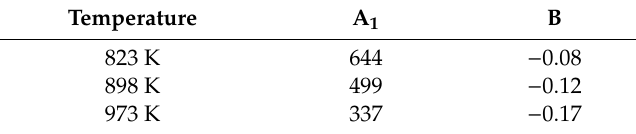
Table 2. Coe ffi cient in the relationship of creep life and stress at di ff erent temperatures.